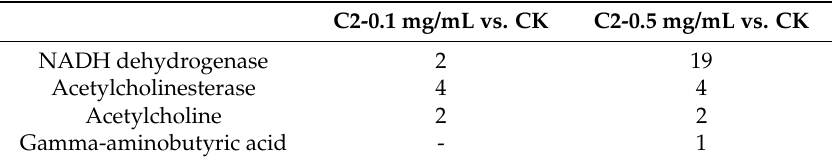
Table 3. Number of pesticide targets of the differentially expressed genes.